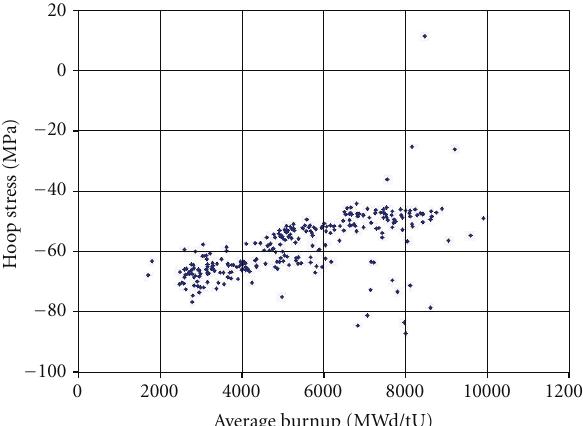
Figure 3: Maximum hoop stress at the inner surface of the cladding calculated for each fuel of the first SEU core of the Atucha 1 NPP.